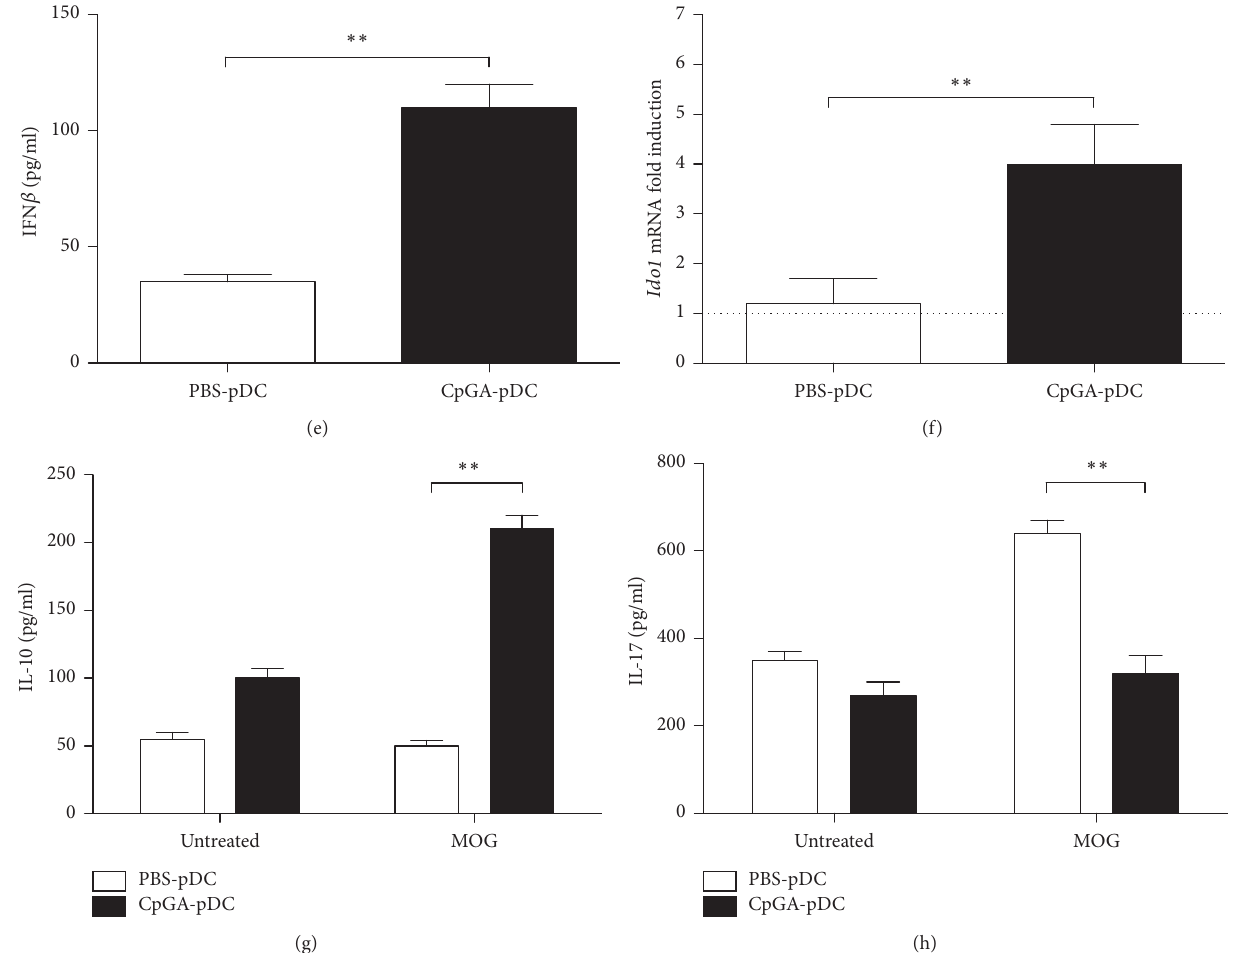
Figure 6: Clinical effect of adoptive transfer of pDCs from mice treated with CpG-A or PBS on EAE. (a) Mice received an i.v. injection of pDCs (5 × 10 5 cells/mouse harvested from mice previously treated with CpG-A (Cp-GA-pDCs) or PBS (PBS-pDC)). Data represent average daily scores ± sem of two independent experiments; 𝑛 = 7 per group, ∗ 𝑝 < 0.05 ; Mann–Whitney 𝑈 test. Clinical parameters of disease scores following PBS-pDC or Cp-GA-pDCs treatment; (b) purity of pDC used for adoptive transfer. Numbers represent percentages of double positive cells. Data are representative of one of two independent experiments; (c) day of disease onset; (d) maximal score. Data represent mean ± sem from three independent experiments; 𝑛 = 7 . Mann–Whitney 𝑈 test; (e) IFN- 𝛽 production from pDCs harvested from PBS or CpG-A-treated animals and cultured for 24h in vitro. Supernatants were tested for the presence of IFN- 𝛽 via ELISA. Data are mean ± sem from two independent experiments; 𝑛 = 7 per group. ∗∗ 𝑝 < 0.01 . Mann–Whitney 𝑈 test. (f) Ido1 mRNA transcripts levels, expression of mRNA being presented relative to respective control, namely, freshly harvested pDCs (in which fold change = 1; dotted line). ∗∗ 𝑝 < 0.01 . (g) Levels of IL-10 and IL-17 measured via ELISA following 72 h MOG (25 𝜇 g/ml) culture of isolated splenocytes. Data represent mean ± sem from three independent experiments, with 𝑛 = 7 mice per group; ∗∗ 𝑝 < 0.01 Mann–Whitney